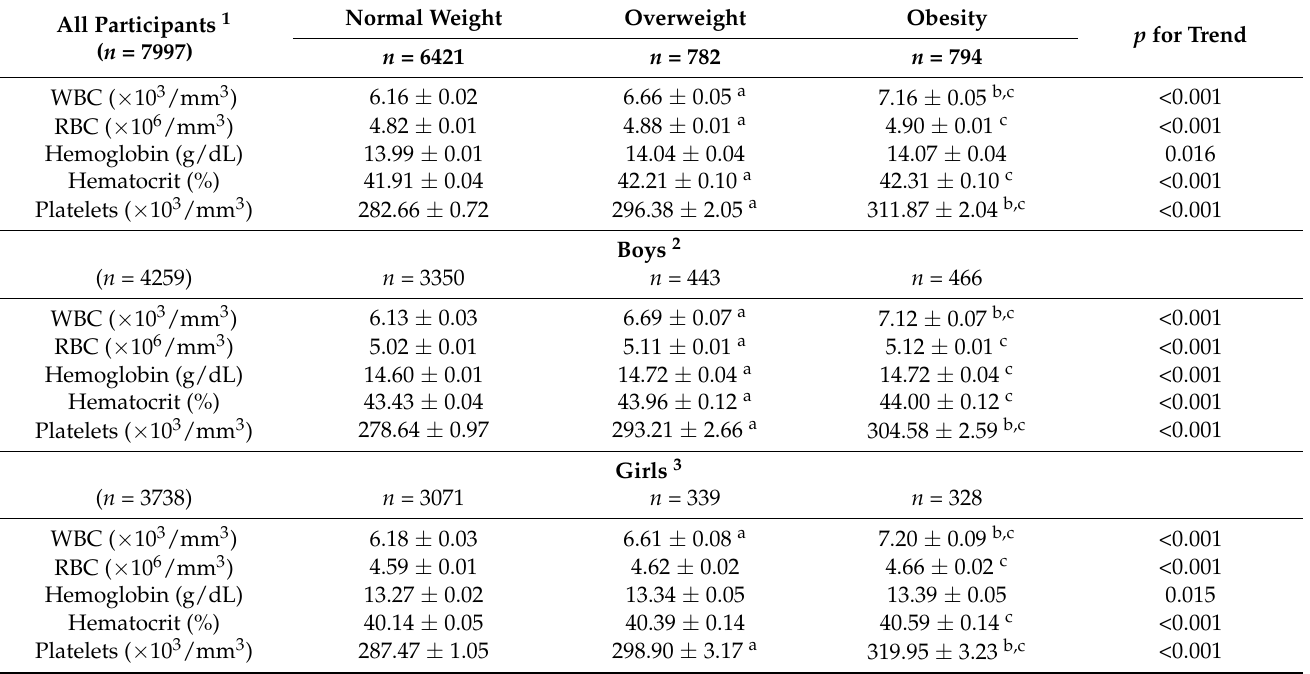
Table 3. Adjusted mean levels of white blood cells, red blood cells, hemoglobin, hematocrit, and platelets by sex and